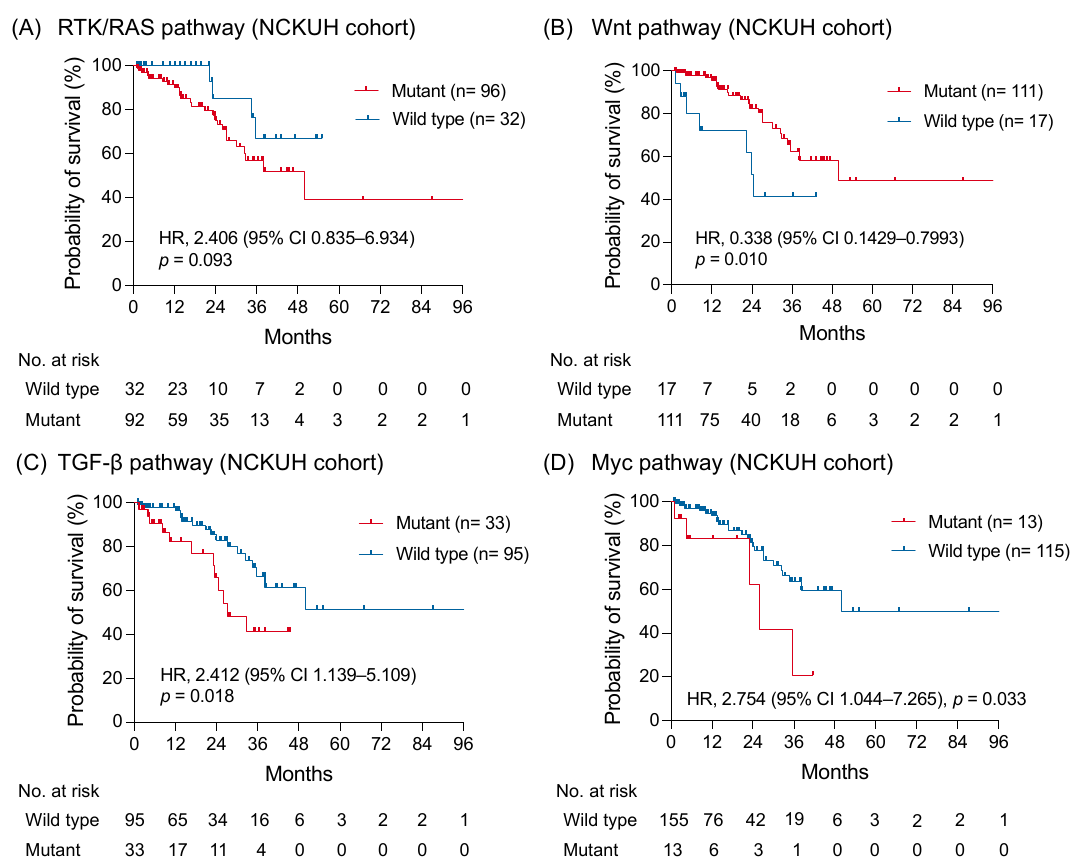
Figure 4. The survival impact of altered signaling pathways. The Kaplan-Meier curves of overall survival in patients with mCRC with and without altered RTK-RAS ( A ), Wnt ( B ), TGF- β ( C ), and Myc pathway ( D ) were shown and compared using a log-rank test. The altered Myc pathway maintained its negative prognostic effect on patients re- ceiving FOLFIRI regimen as first-line treatment (HR: 3.568; 95% CI: 1.428–9.589; p = 0.006; Figure 5D). A trend appealing a shorter OS was found in patients with tumor carrying Myc pathway alterations compared to those without alterations whether an anti-EGFR or VEGF antibody was used as first-line treatment (HR: 5.109; 95% CI: 0.827–31.56; p = 0.05 and HR: 3.076; 95% CI: 0.902–10.49; p = 0.05, respectively; Figure 5E,F). Among 13 patients with MYC mutation, 4 (30%) patients simultaneously harbored BRAF V600E mutation. Patients with either MYC or BRAF mutations were associated with a worse OS compared with those without mutation (Figure S5B,C). Moreover, patients with MYC and BRAF mutation co-occurrence had a shorter OS than those with either MYC or BRAF mutation (HR: 9.772; 95%CI: 0.8739–109.3; p = 0.02; Figure